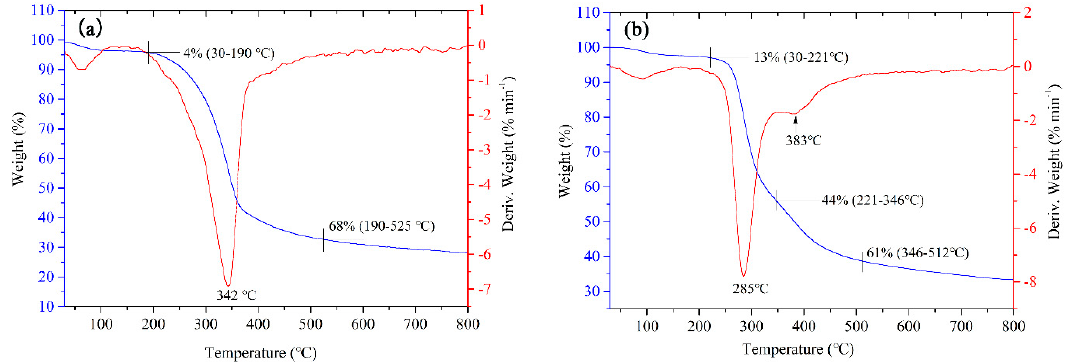
Figure 3. TG and DTG curves of ( a ) peanut shell powder and ( b ) liquefaction residue.